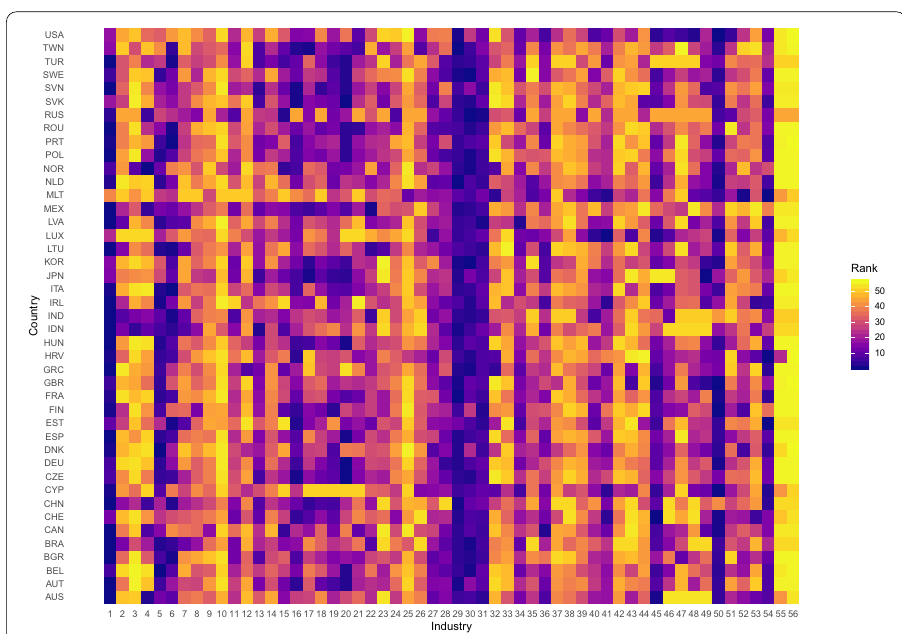
Fig. 4 Absolute total potential employment effects of a decline in UK import demand for final goods from the EU (no‑deal Brexit) by country and industry. Light color: relative small effect, dark color: relative large effect. Based on ranked absolute total (direct and indirect) employment effects by country of a decline in British final goods imports due to tariffs and non‑tariff trade costs after a no‑deal Brexit derived from input– output analysis. General‑equilibrium effects and other relevant channels such as trade diversion are not included. Source: World Input–Output Database, data for 2014, and own